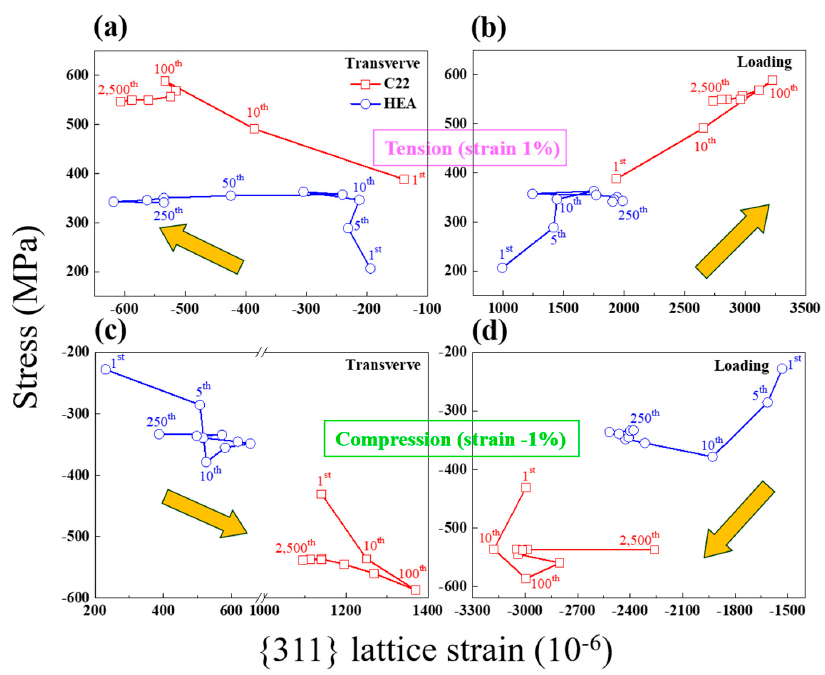
Figure 3. The {311} lattice strain-stress relationship at the maximum tensile strain of 1% in ( a ) transverse and ( b ) axial loading; and at the maximum compressive strain of − 1% in ( c ) transverse and ( d ) axial loading directions for both the C22™ and CoCrFeMnNi alloys.